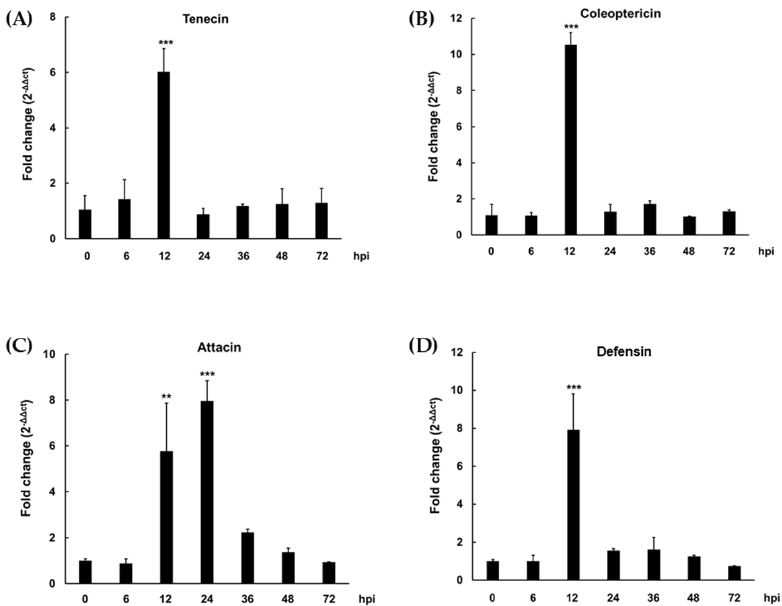
Figure 1. Gene expression of tenecin ( A ), coleoptericin ( B ), attacin ( C ), and defensin ( D ) in Tenebrio molitor larvae (TML). Values are reported as mean ± standard deviation of triplicate experiments. ** p < 0.01 and *** p < 0.001 indicate significant difference between the 0 h and 6, 12, 24, 36, 48, and 72 h post infection (hpi), respectively.